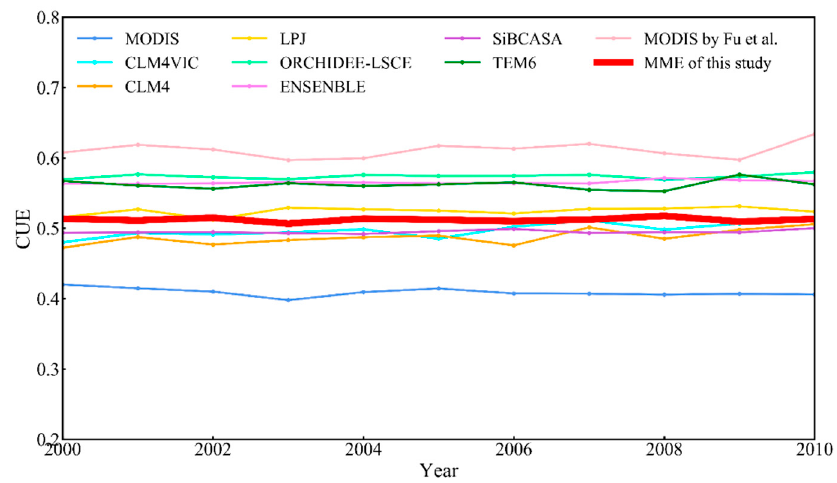
Figure A4. Comparison and interactive verification of CUE of different research results over the Qinghai-Tibet Plateau during 2000–2010. The thick red line represents the CUE of the multiple model